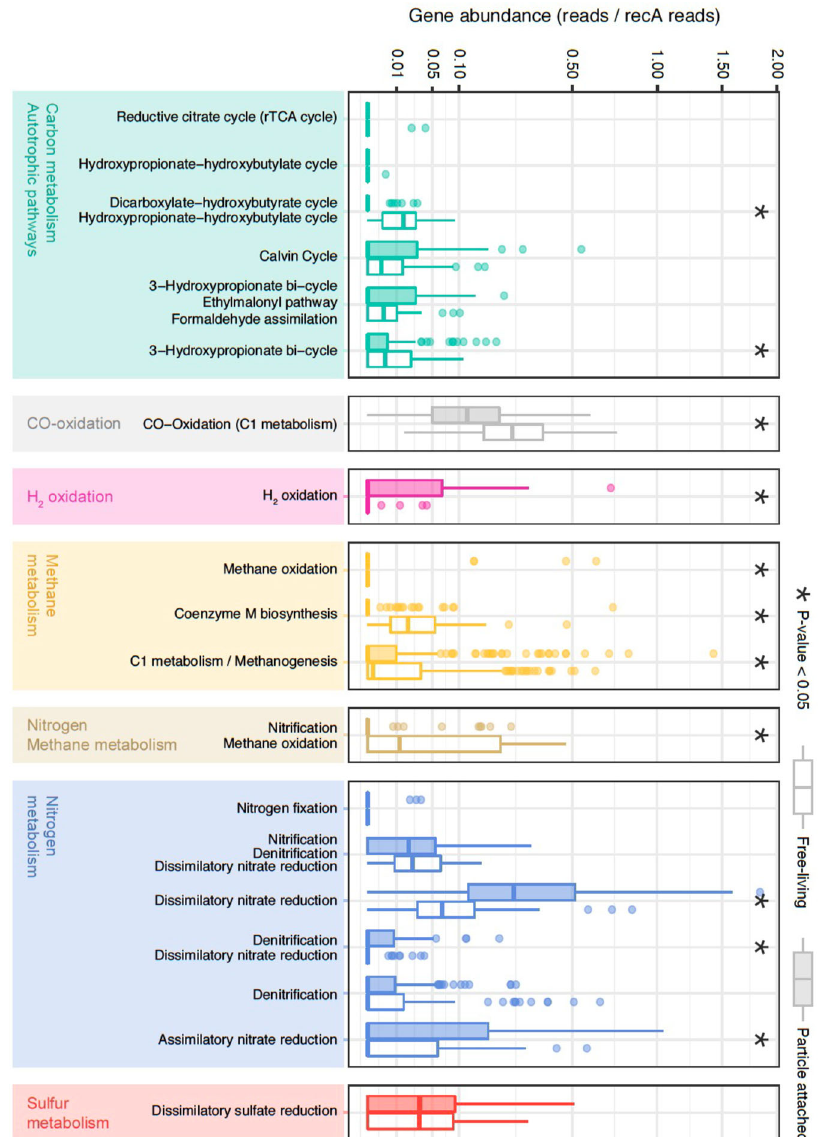
Fig. 4 Comparison of metabolic pathways in the free-living and particle-attached microbial communities from the bathypelagic ocean. Normalized gene abundance (reads/ recA reads) of 49 marker genes indicative of different autotrophic carbon- fi xation pathways, nitrogen, sulfur, methane, and hydrogen metabolisms in the Malaspina Gene DataBase. Gene abundances from KOs belonging to the same pathway and KEGG module level have been plotted together (Supplementary Data 7). From top to the bottom: Reductive citrate cycle (rTCA): K15230, K15231); hydroxypropionate – hydroxybutyrate cycle: K15039; dicarboxylate-hydroxybutyrate cycle|hydroxypropionate-hydroxybutylate cycle: K15016; Calvin cycle: K00855; K01601 and K01602; 3- hydroxypropionate bi-cycle|ethylmalonyl pathway|formaldehyde assimilation: K08691; 3-hydroxypropionate bi-cycle: K14468, K14470 and K09709; CO oxidation (C1 metabolism): K03520; K03519 and K03518; H 2 -oxidation: K00436; methane oxidation: K16158; coenzyme M biosynthesis: K05979, K06034, K08097 and K13039; C1 metabolism/methanogenesis: K00320, K00200, K00201, K00202, K00672, K03390, K14083, and K00577; nitri fi cation|methane oxidation: K10944, K10945, and K10946; Nitrogen fi xation: K02588; nitri fi cation|denitri fi cation|dissimilatory nitrate reduction: K00370 and K00371; dissimilatory nitrate reduction (DNRA): K00362 and K00363; denitri fi cation|dissimilatory nitrate reduction: K00374, K02567, and K02568; denitri fi cation: K00368, K15864, K04561, K02305, and K00376; assimilatory nitrate reduction: K00367 and K00372; dissimilatory sulfate reduction: K00394, K00395 and K11181. Wilcoxon tests were done to test for signi fi cant differences between the particle-attached (PA) and free-living (FL) assemblages and signi fi cant ( P value < 0.05) differences are labeled with asterisks. FL (empty boxes) and PA ( fi lled boxes) bathypelagic microbial communities are shown next to each American basin, Atlantic Ocean) where it peaked up to 12% of distribution restricted to a single station each: St62 and St53, the cells (Fig. 3). However, there were no signi fi cant differences respectively, both in the Indian Ocean (Fig. 3). RuBisCO occurred between both size fractions (Wilcoxon test, P value = 0.135). in 48% of the samples (Supplementary Data 8), and on 1.3% of Nitri fi cation through ammonia 15,50,51 and nitrite oxidation 18 the potential cells on average (based on recA normalization) with two signi fi cant deviations observed in the PA fractions at St67 have been postulated as the main sources of energy for carbon fi xation in the dark ocean. For ammonia oxidation, we looked for (South Australian Bight, Indian Ocean) and St134 (North